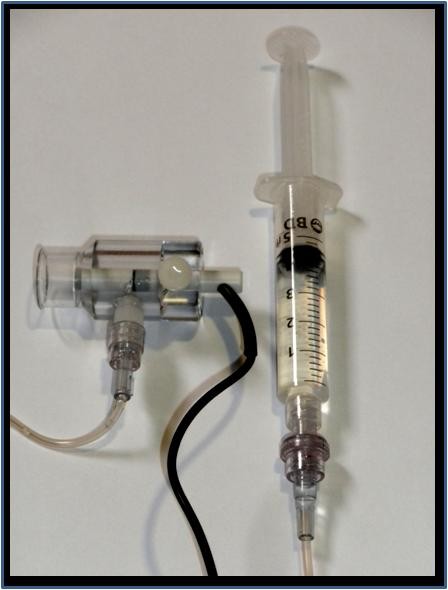
Immersion probe and PalmScan™ device main display.